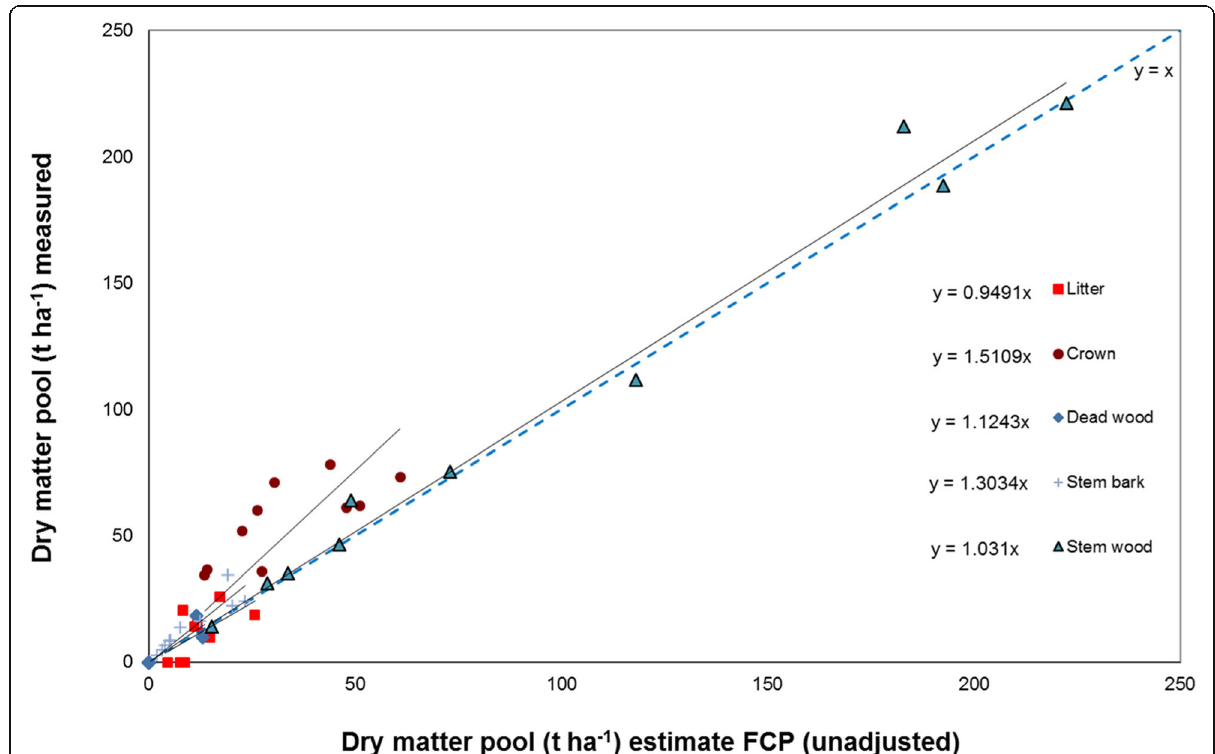
Fig. 1 Relationship between measured dry matter (DM) in Douglas-fir stands and modelled dry matter estimates in stands of the same age, mean top height, basal area, stocking, and silvicultural regime from the Forest Carbon Predictor